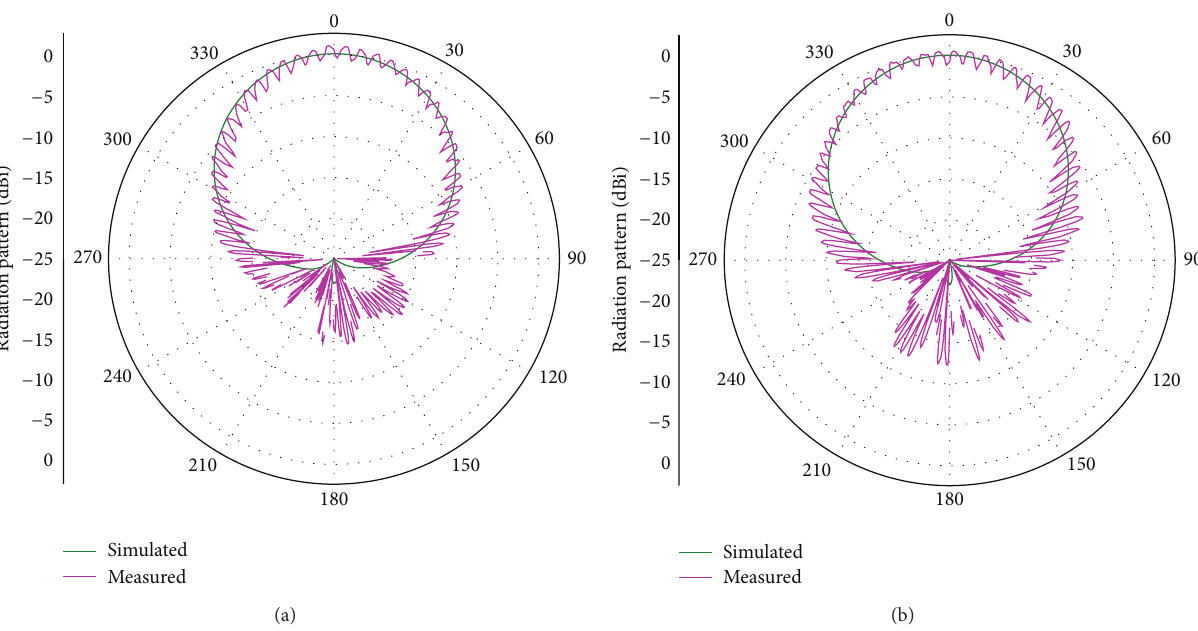
Figure 10: Radiation pattern of the proposed antenna at the centre frequency of 3.7 GHz. (a) in the plane of 0 ∘ . (b) In the plane of 90 ∘ .